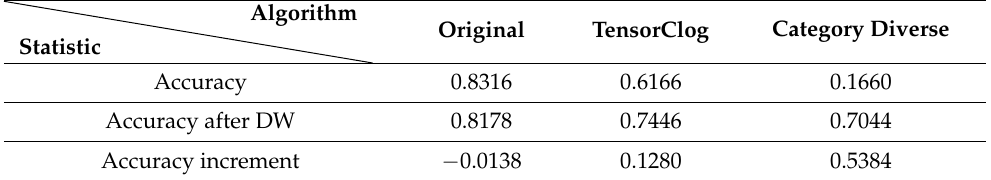
Table 2. Effectiveness of Data Washing algorithm in mitigating effects of paralysis attacks on Resnet18 [10].